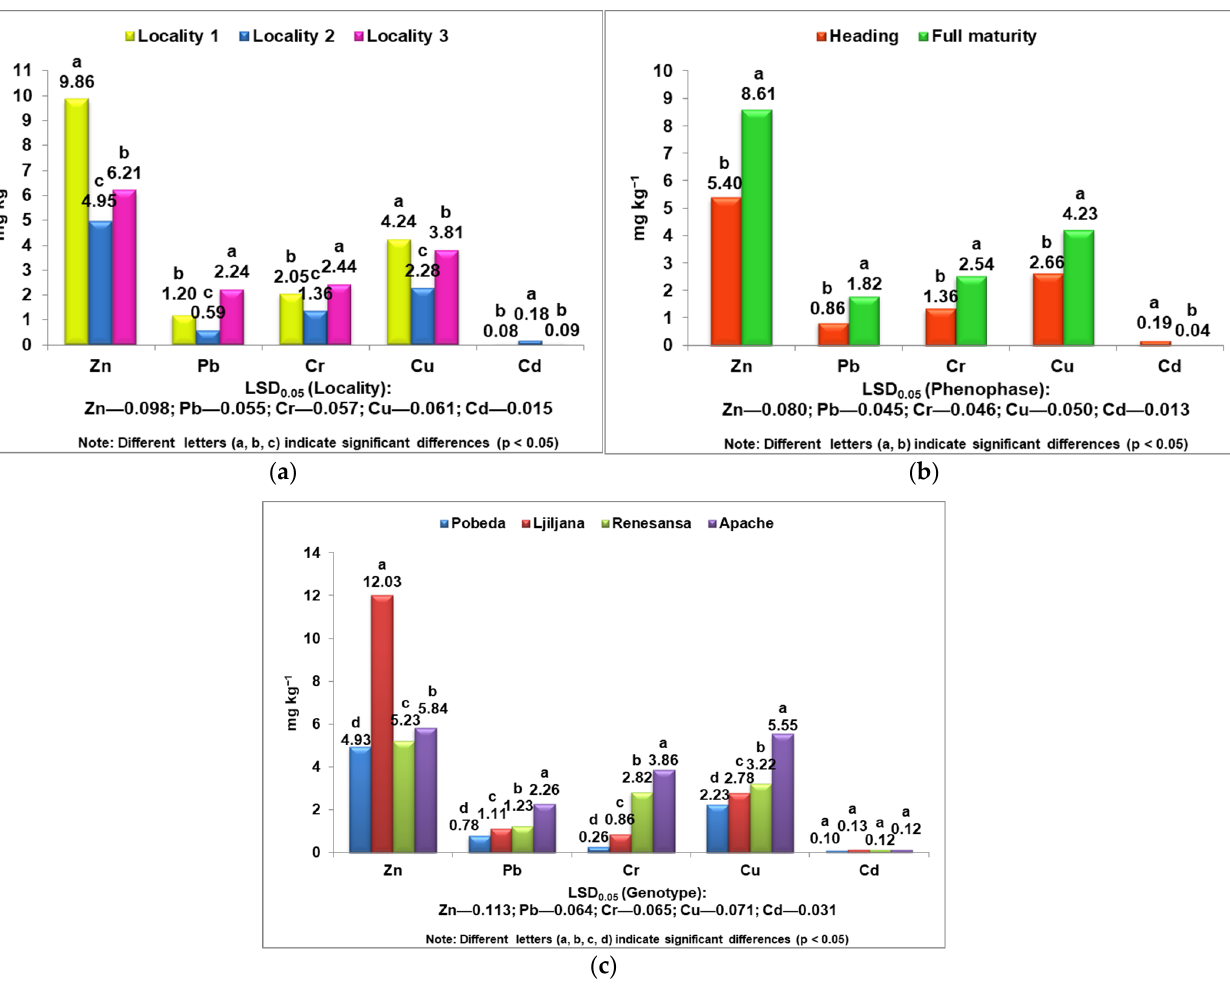
Figure 4. Heavy metal content (mean values, mg kg − 1 ) in wheat stems: ( a ) averaged per localities (average values of four genotypes in two phenophases); ( b ) averaged per phenophases (average values of four genotypes at three localities); ( c ) averaged per genotypes (average values of each genotype at three localities and two phenophases).